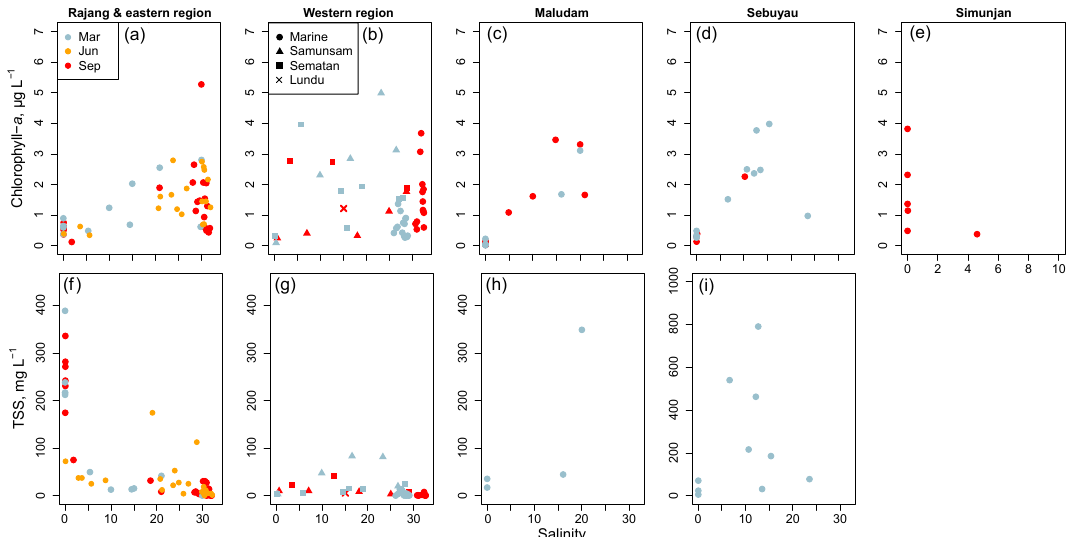
Figure 7. Distribution of (a–e) chlorophyll- a , and (f–i) total suspended solids from rivers to coastal seawater for each study region. TSS was not measured in the